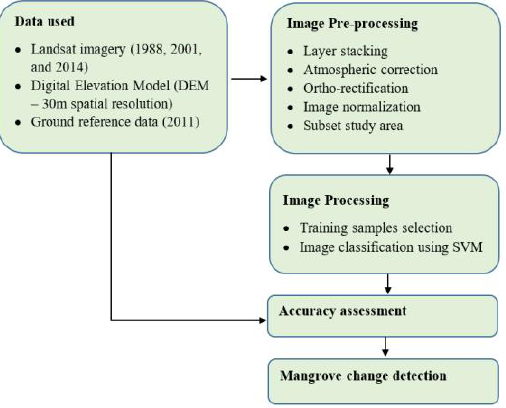
Figure 2. Flow chart of the methodology used for extract mangrove in the study